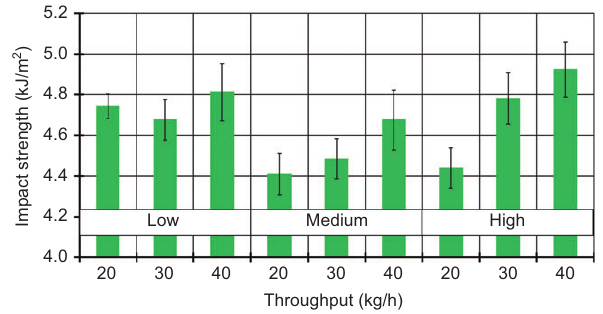
Figure 8 Notched impact strength for different screw configura- tions at 20, 30, and 40 kg/h.